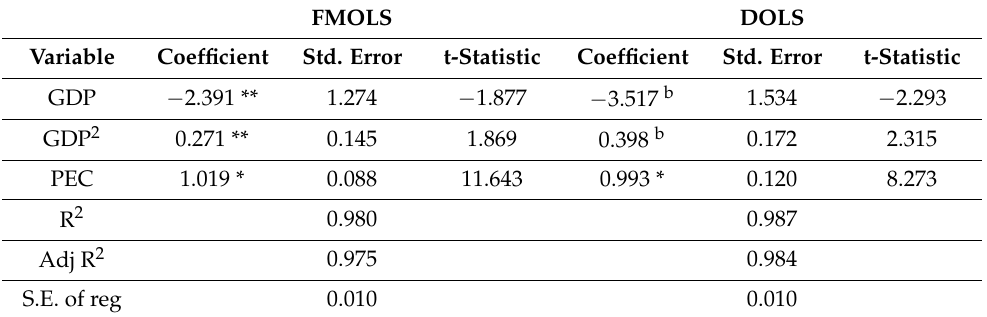
Table 8. FMOLS and DOLS.